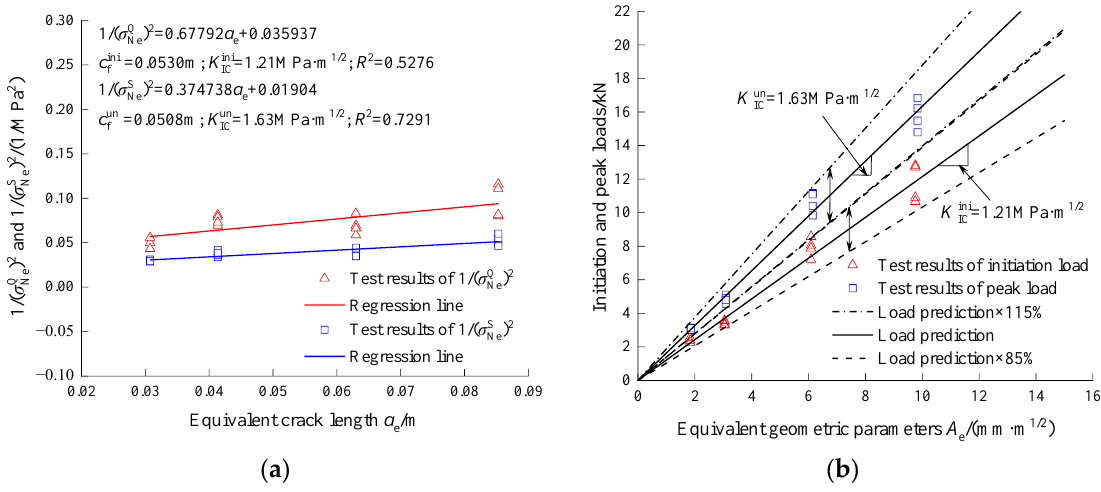
and Cov = 24.75 ( kN ) 2 . The calculation results show that the initiation and peak load test results are close to the predicted results.